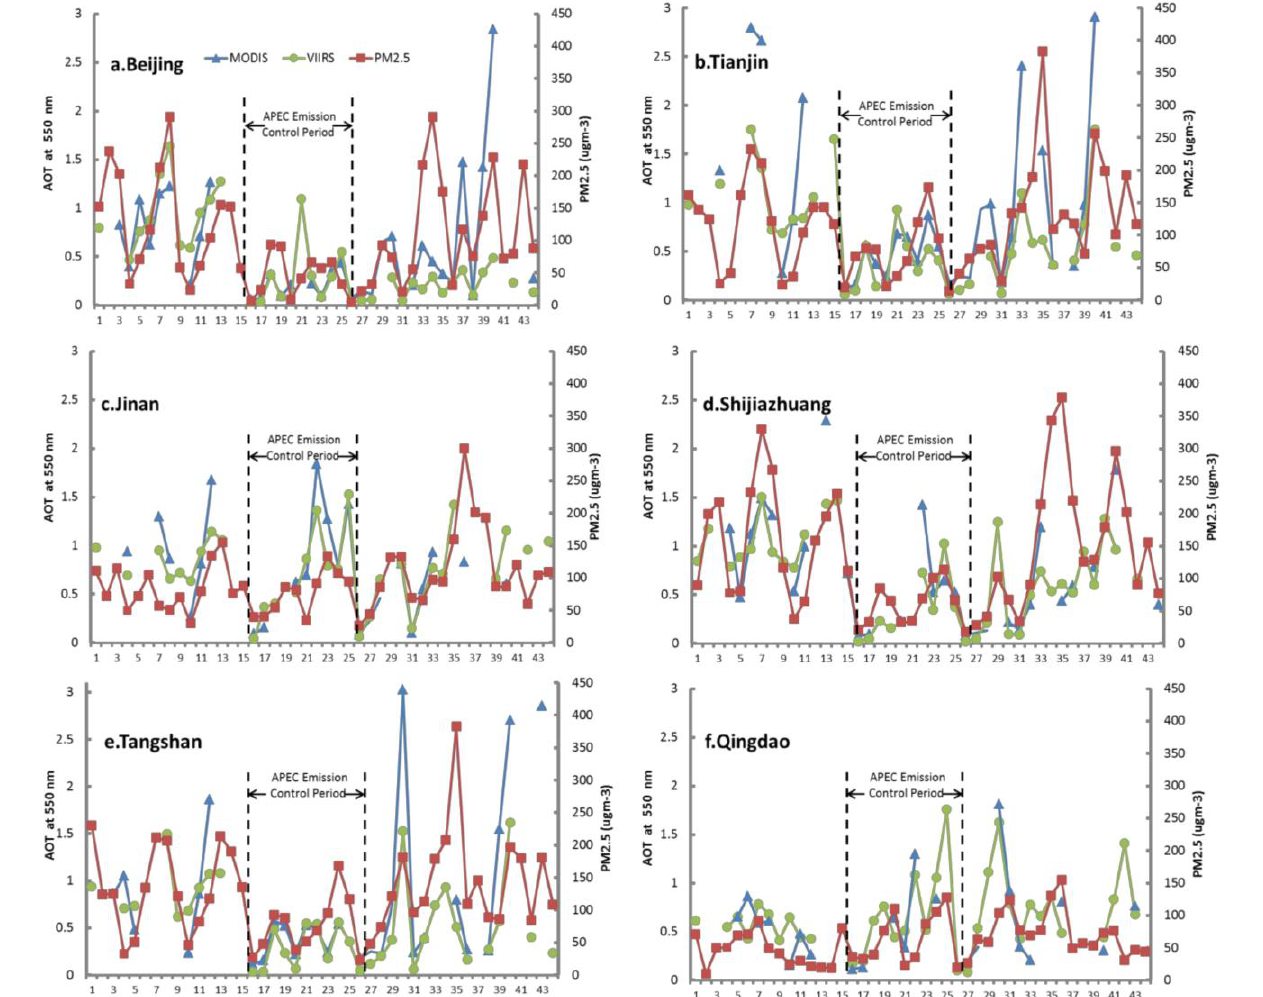
Figure 2. Daily satellite-retrieved mean AOT and ground PM 2.5 during three periods in six cities: pre-APEC (18–31 October, No. 1–14), APEC (1–11 November, No. 15–25), and post-APEC (12–30 November, No. 26–44) in 2014; No.1 on the x-axis denotes 18 October and so